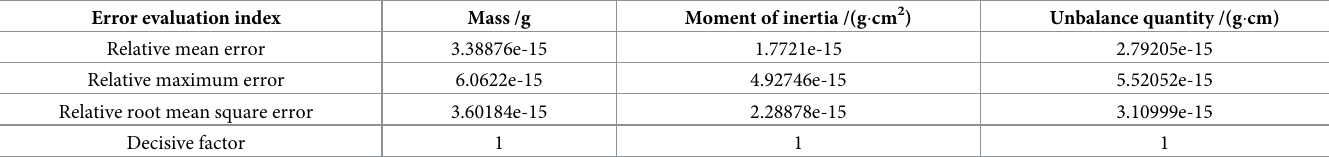
Table 4. Error evaluation of the radial basis function response mapping